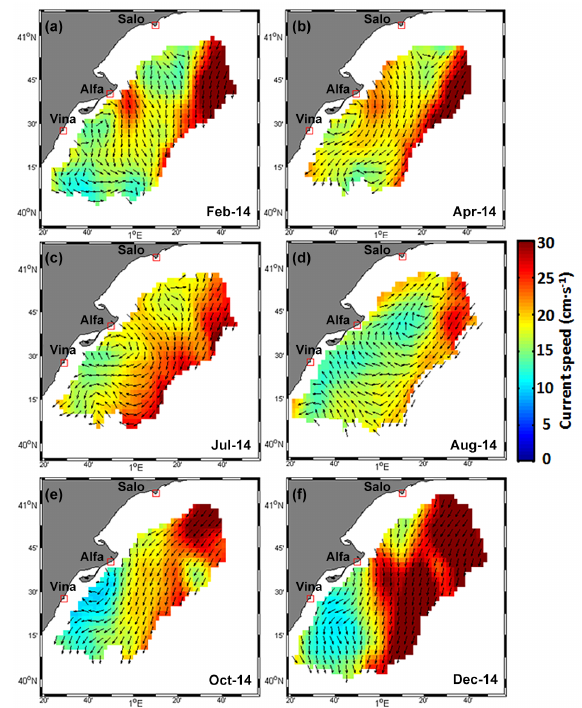
Figure 9. Monthly averaged surface velocity fields, based on unfil- tered hourly HF radar current data, for (a) February, (b) April, (c) July, (d) August, (e) October, and (f) December 2014. The study area is not uniformly covered since only radar grid points satisfying a minimum data return of 50% over the monthly record have been considered. Only one grid point of every two is plotted for visual- ization